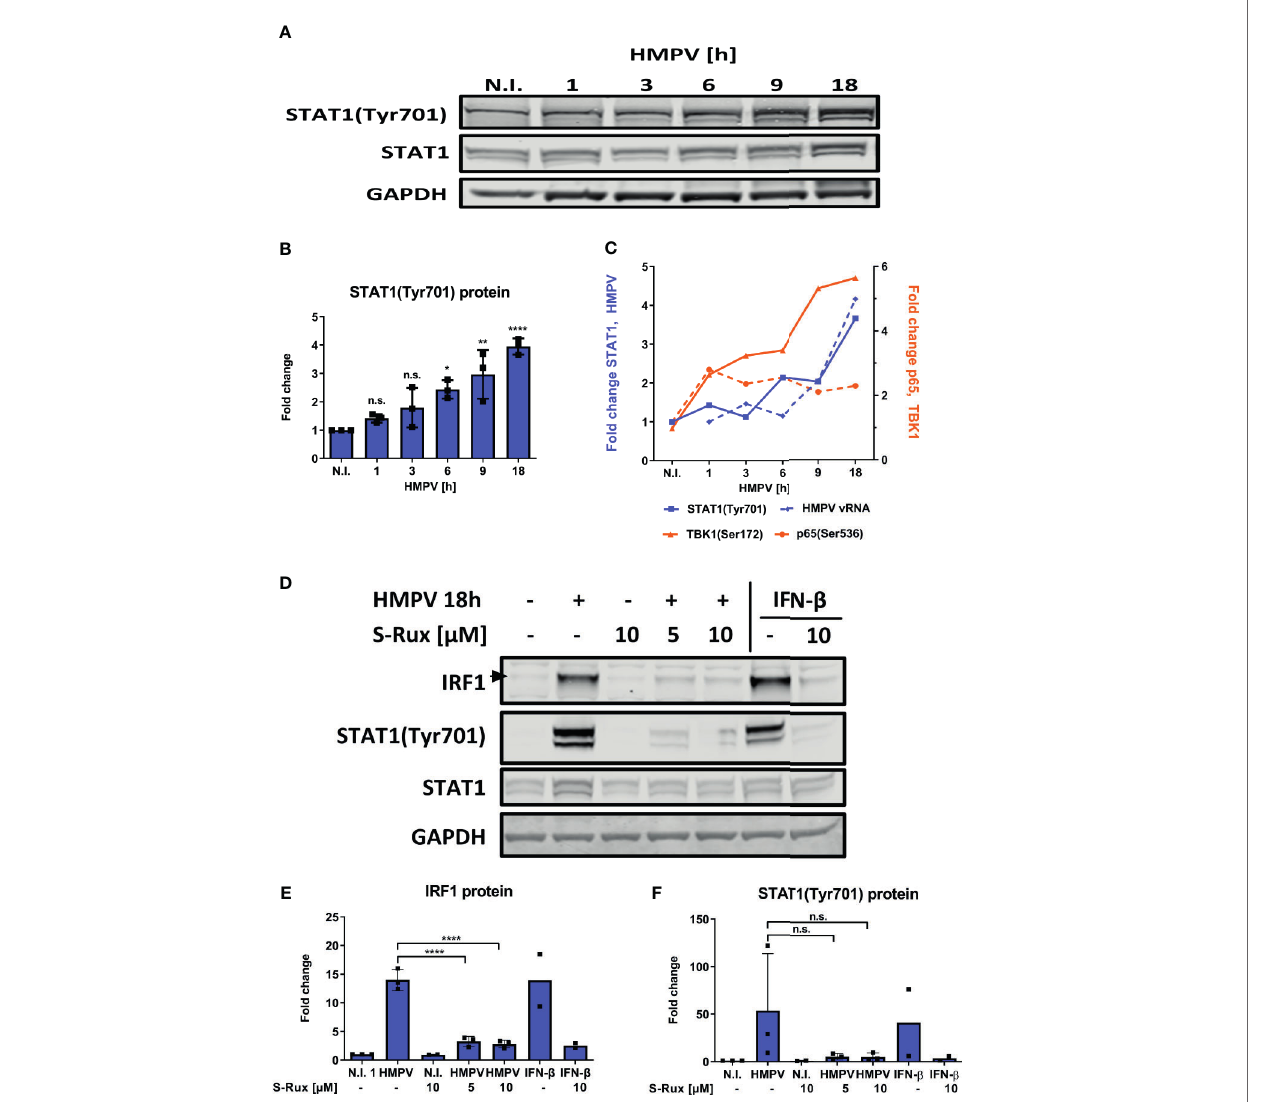
FIGURE 6 | HMPV-induced expression of IRF1 is dependent on STAT1 activation. (A, B) Human MDMs were infected for the indicated timepoints with HMPV or treated with medium ( “ N.I. ” ). Whole cell lysates were prepared and protein levels of STAT1 and p-STAT1(Tyr701) were analyzed by immunoblotting. (B) Protein levels of p-STAT1(Tyr701) were quanti fi ed by normalization of band intensities against GAPDH and are presented as fold change relative to uninfected cells ( “ N.I. ” ). (C) Comparison of quanti fi ed p-STAT1(Tyr701), HMPV N-protein, p-TBK1(Ser172) and p-p65(Ser536) levels (presented in Figures 1C , 3A , 4A and 5A ). (D) Human MDMs were preincubated with the indicated concentration of S-Ruxolitinib prior to infection with HMPV (18 h) or treatment with IFN- b (3 h). Whole cell lysates were prepared and protein levels of IRF1, STAT1 and p-STAT1(Tyr701) were analyzed by immunoblotting. Protein levels of IRF1 (E) and p-STAT1(Tyr701) (F) were quanti fi ed by normalization of band intensities against GAPDH and are presented as fold change relative to uninfected cells ( “ N.I. ” ). Statistical analysis: Two-way ANOVA with Tukey ’ s honest signi fi cance test: ∗ p < 0.05; ∗∗ p < 0.01; ∗∗∗∗ p < 0.0001. n.s., not signi fi